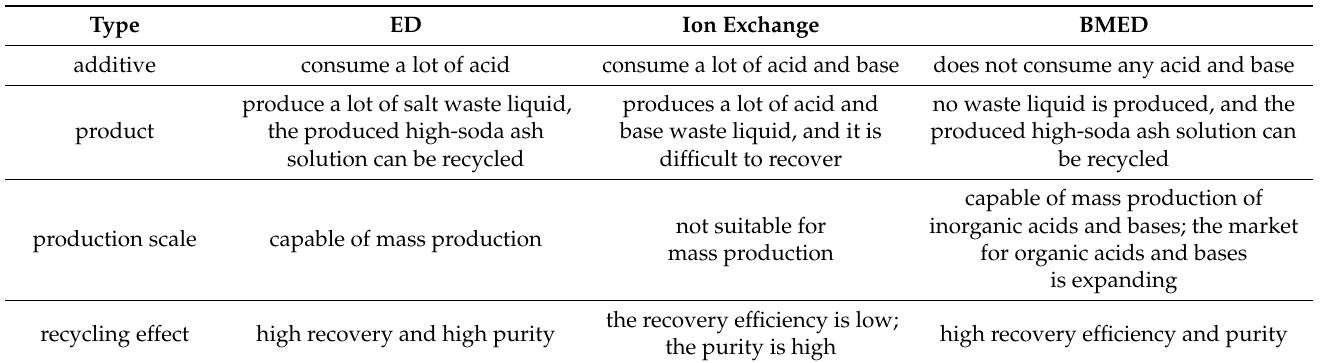
Table 1. A comparison of BMED and other membrane